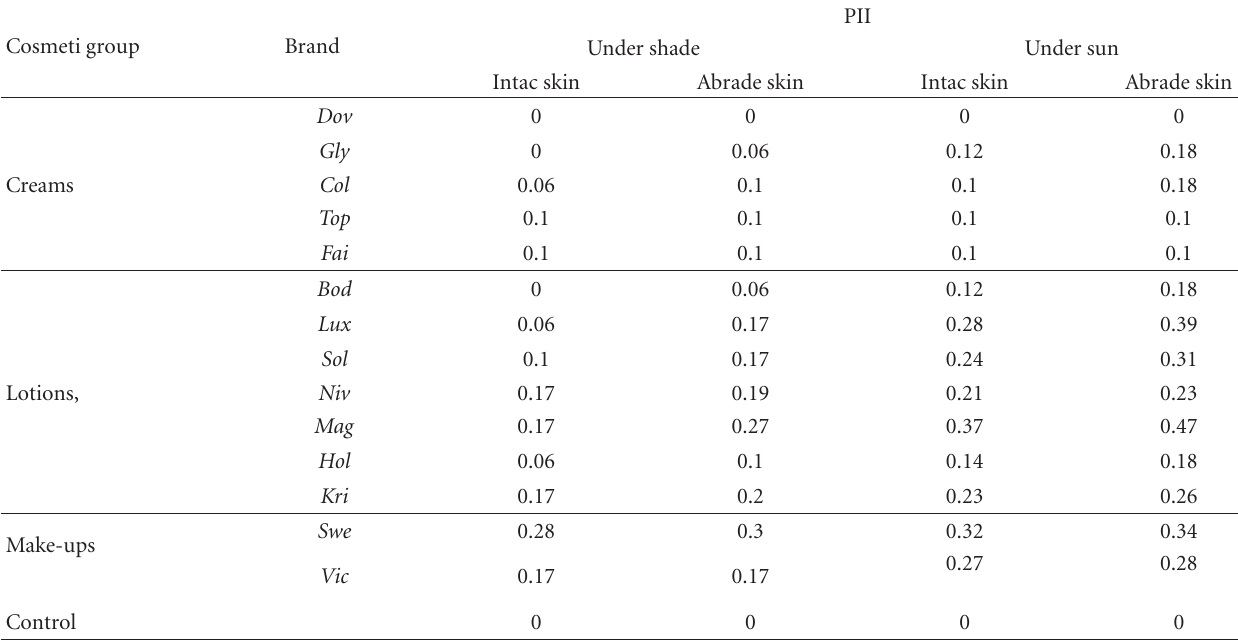
Table 3: Primary irritation index (PII) of creams, lotions and make-ups applied once on intact and abraded rabbit skin, calculated from combined erythema and edema ratings for three rabbits at three observation periods (24, 48, and 72 h), Jimma, 2011. Cosmeti group